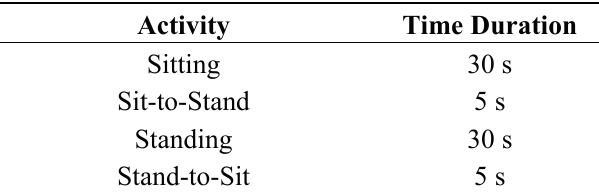
Table 6. Daily life activity.